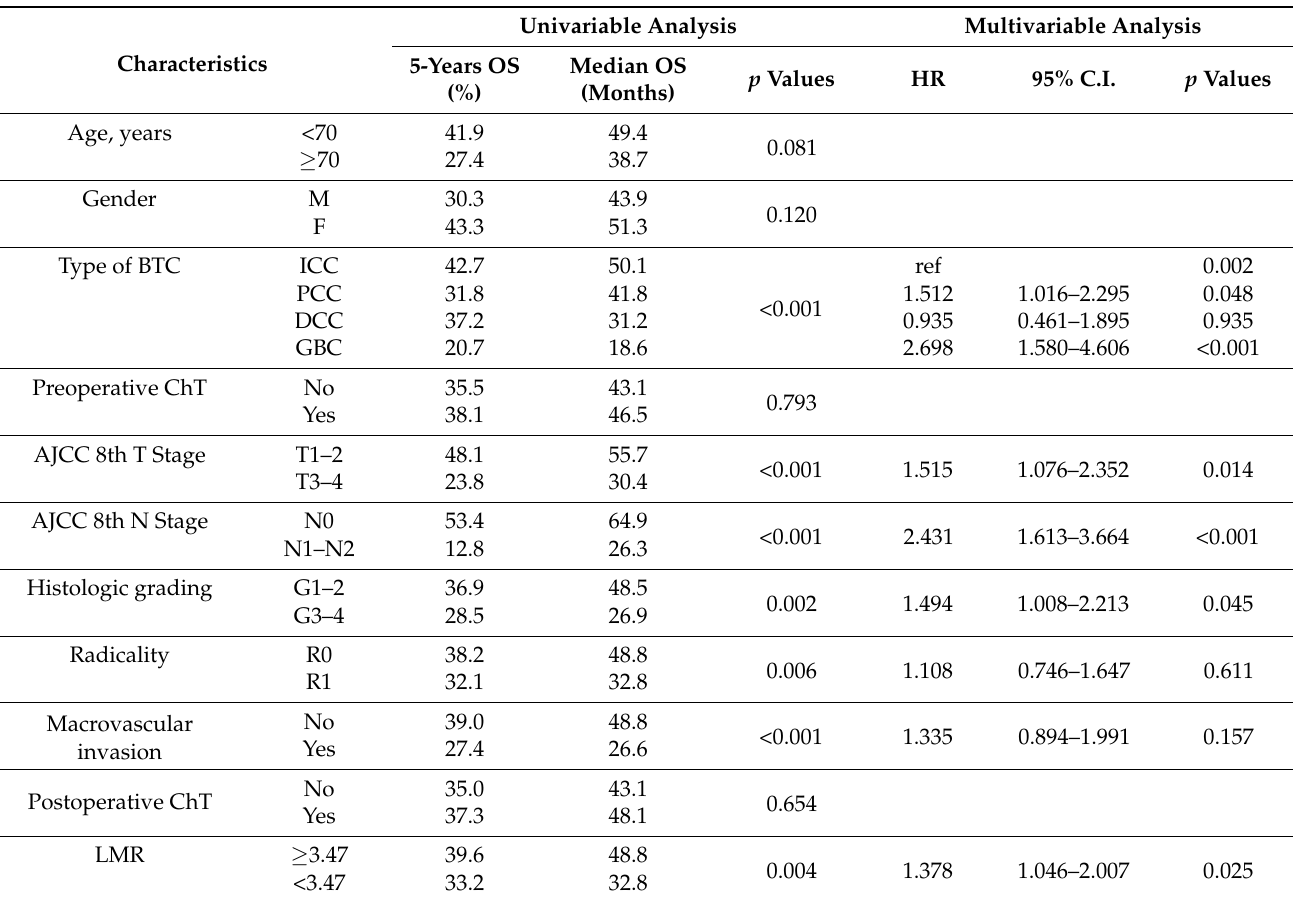
Table 5. Univariable and multivariable analysis for overall survival.